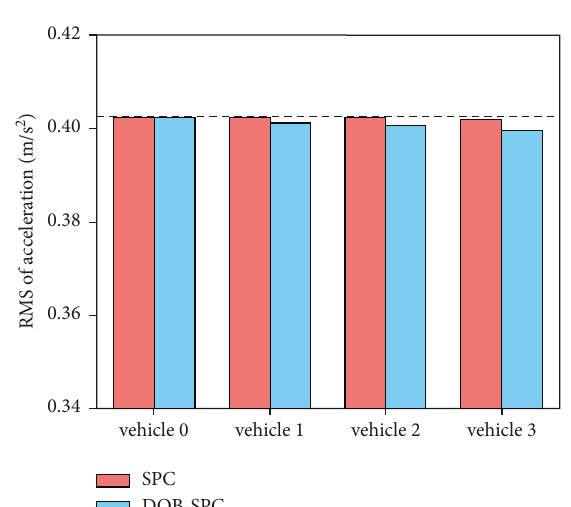
Figure 19: The comparison of acceleration root mean square values in two sets of simulation